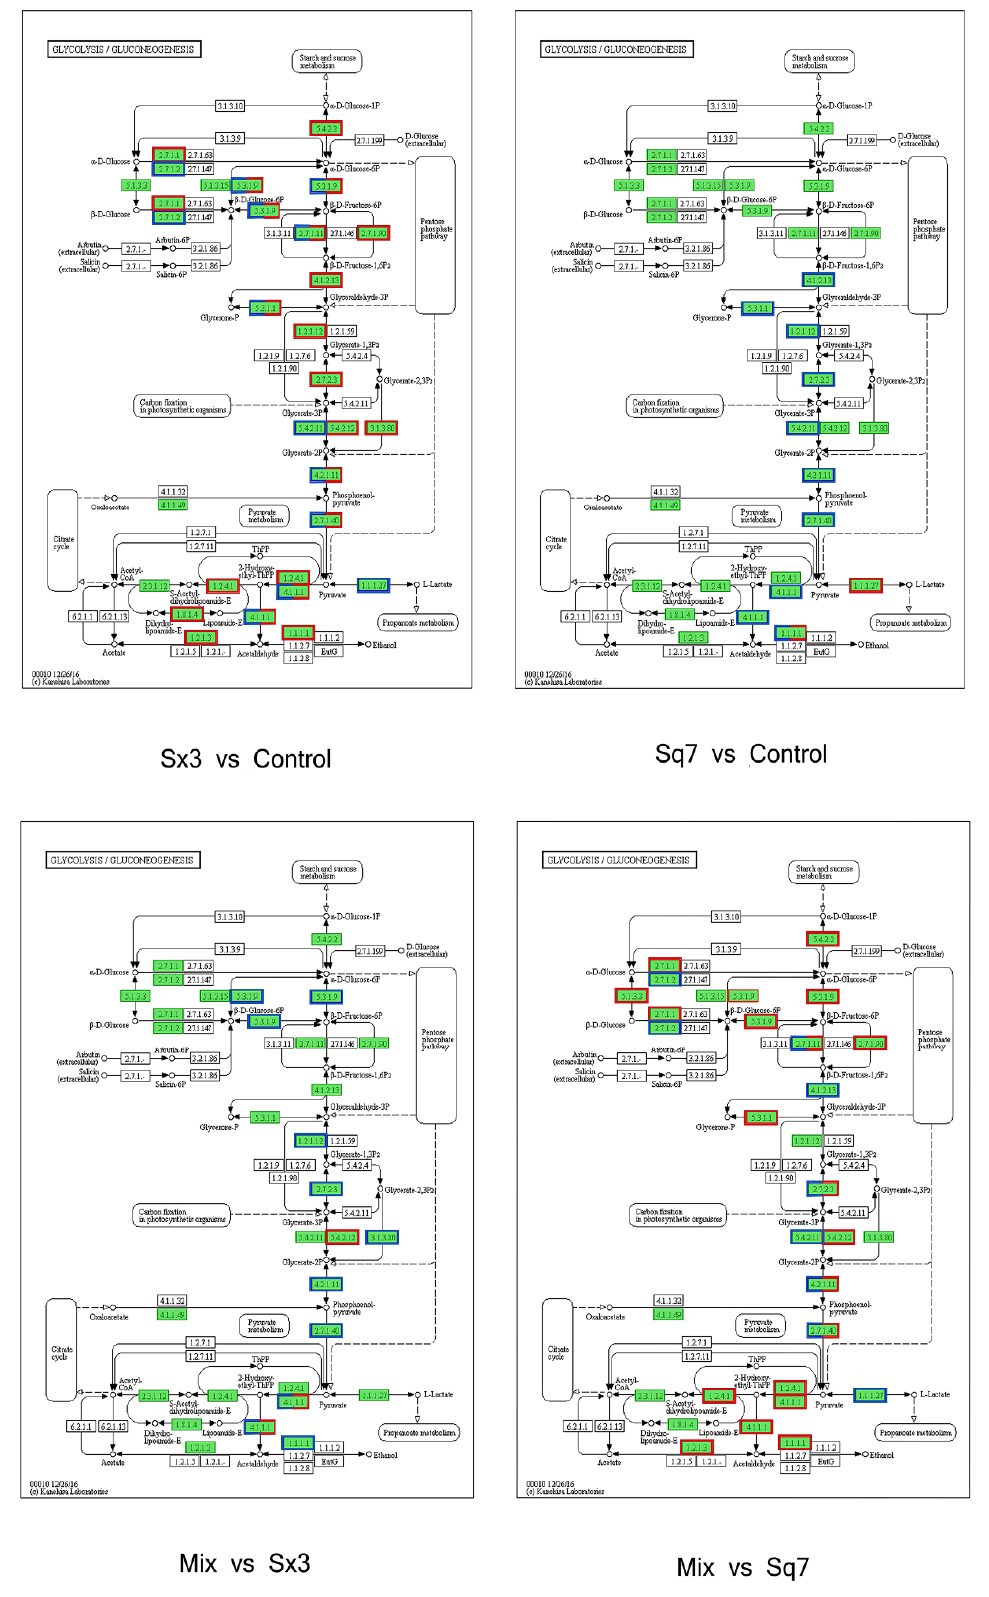
Figure 5. Glycolysis KEGG function annotation, the enzymes coloured in blue represent upregulated, in red represent downregulated enzymes according to proteomic